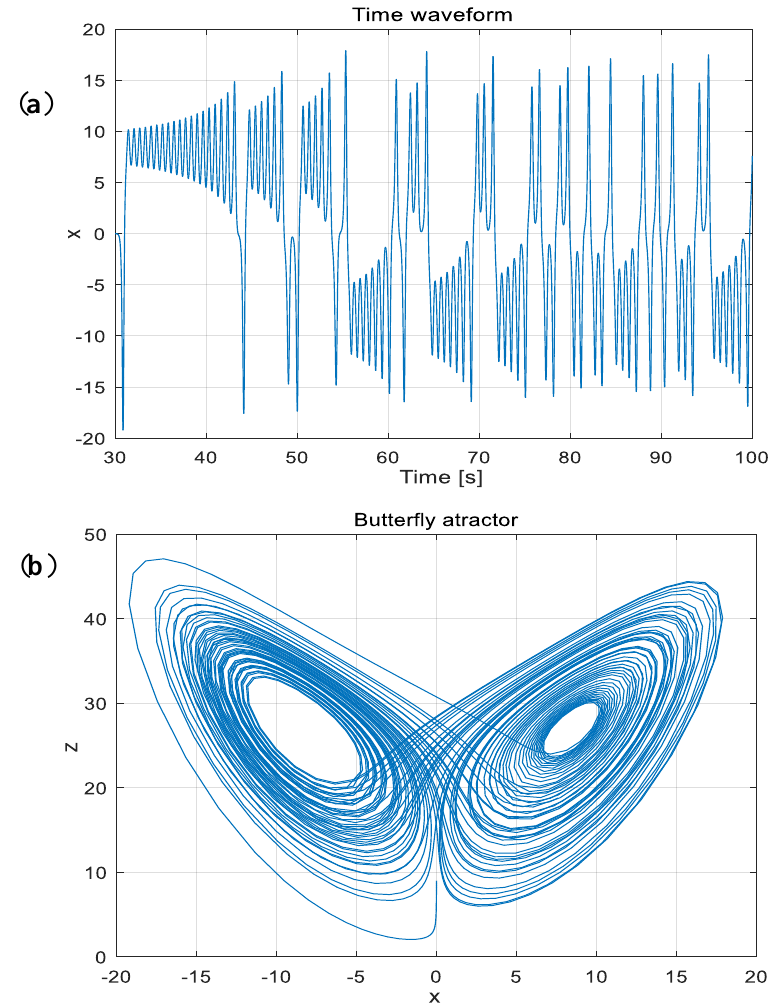
Figure 2. ( a ) Signal waveform from Lorenz system; ( b ) Butterfly attractor.